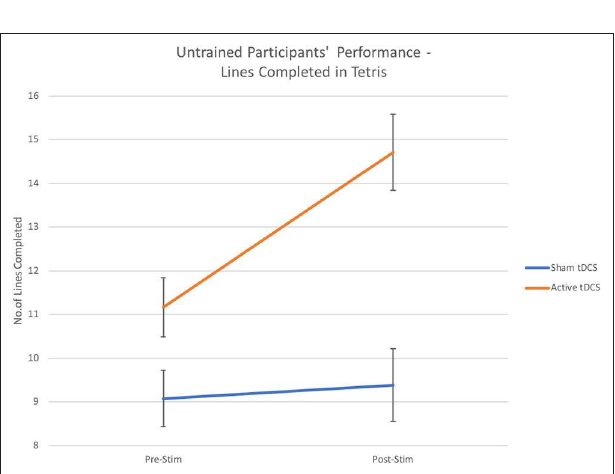
FIGURE 4 | Number of completed lines—performance scores from untrained participants after Active Stimulation and Sham Stimulation. Bars—Standard